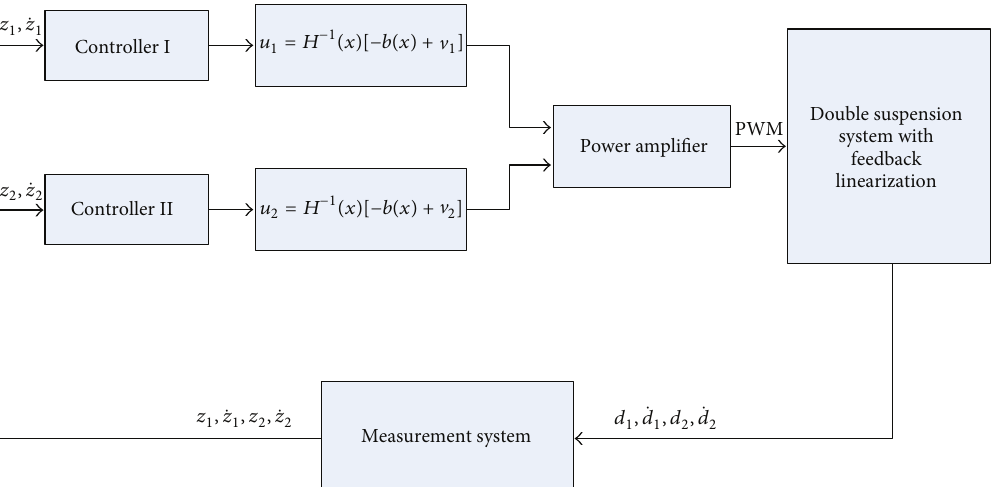
Figure 4: Block diagram of double suspension points system.